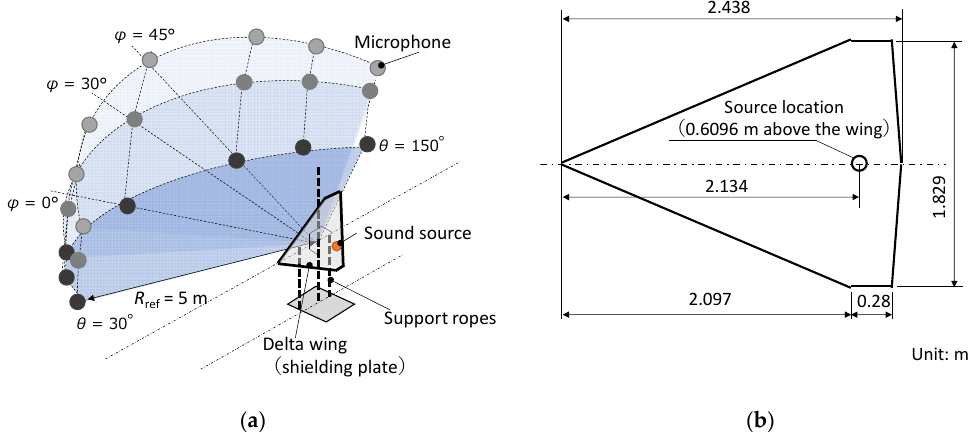
Figure 8. Schematics of scale model tests of the fan noise shielding effect: ( a ) experimental setup; ( b ) test model and the source location.